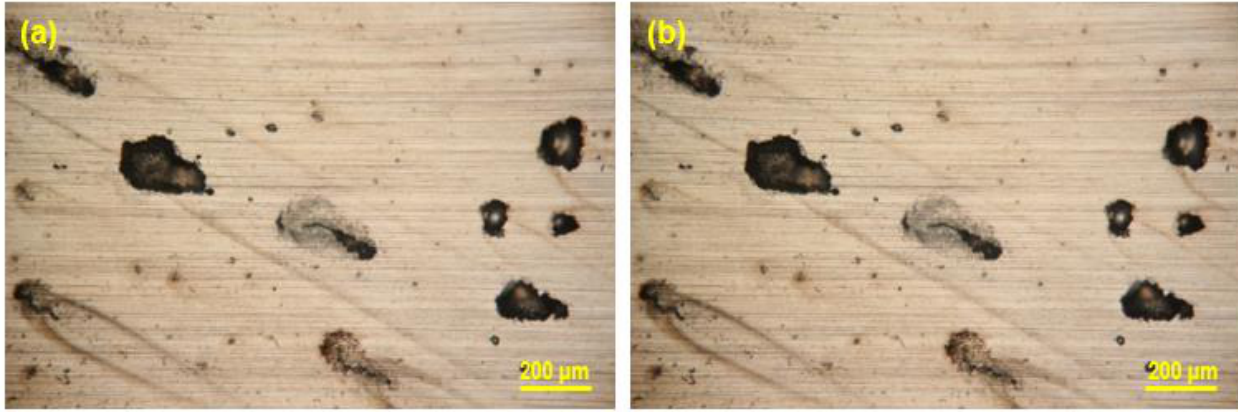
Figure 11. Optical micrographs after potentiodynamic polarization measurements in seawater at 298 K in the presence of 10 ppm of S 2− for ( a ) AISI 304L and ( b ) AISI 316L (100× magnification).